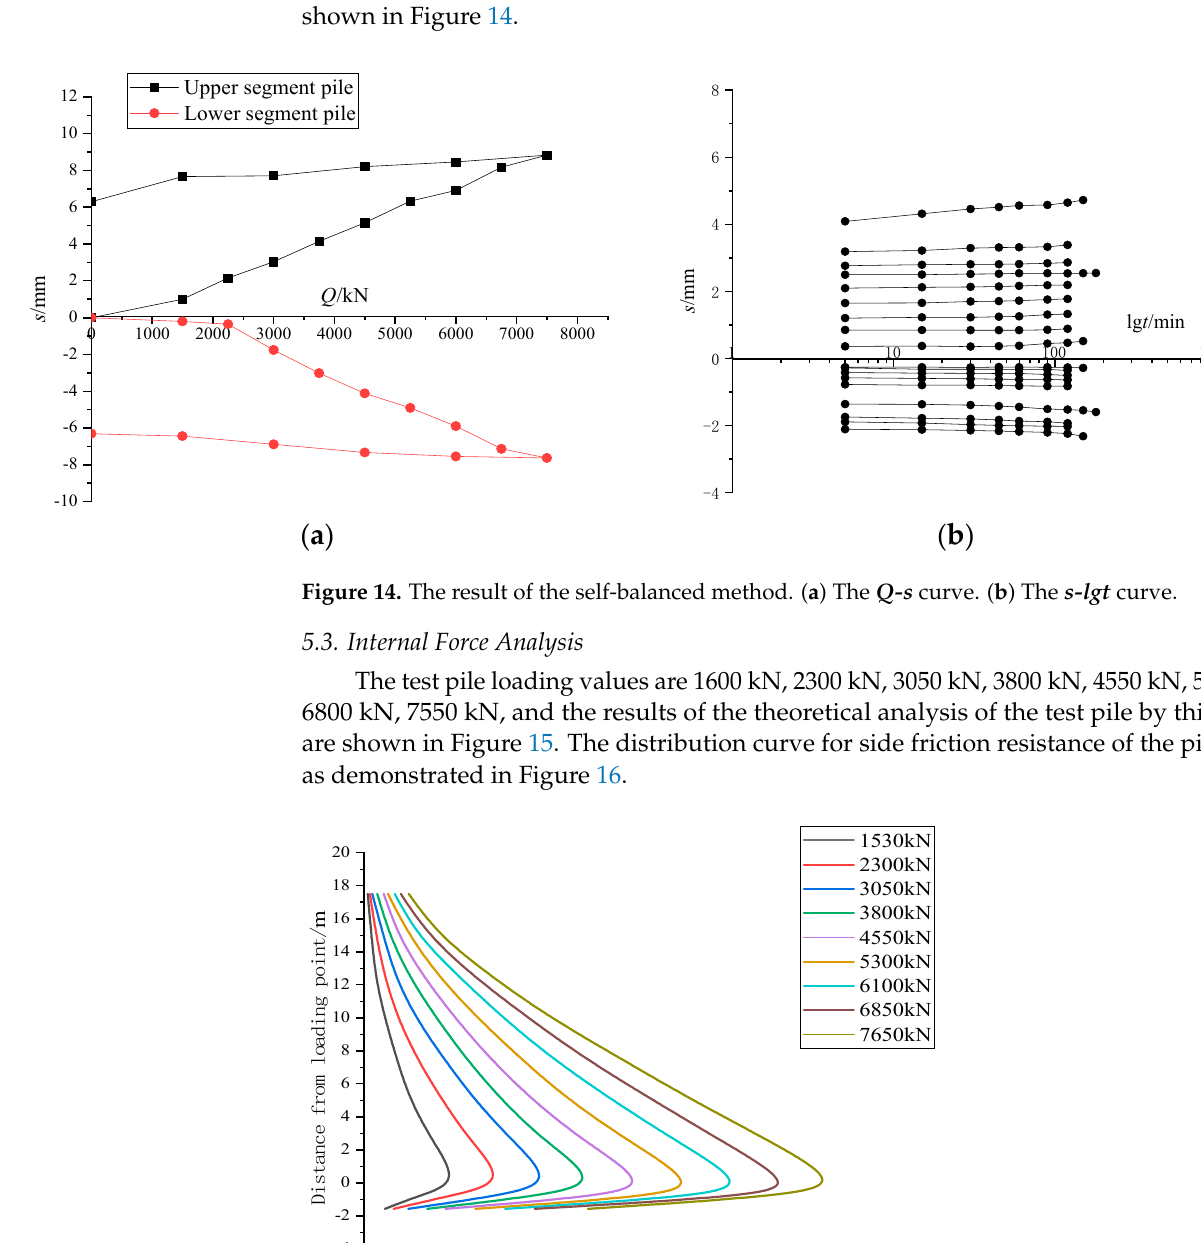
-8.700 Figure 13. Self-balanced method load test soil layer distribution diagram. 5.2. Test Result According to the estimated ultimate bearing capacity, the test is carried out at 10 lev- els of loading from small to large. When the load reaches the 10th level of 7500 kN, the load box reached a largely steady condition after 1320 min observations. The uplift of the upper plate was 8.83 mm, and the total settlement of the lower plate is 7.63 mm. The set-